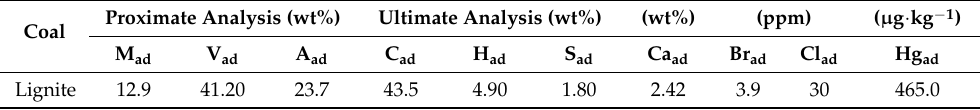
Table 5. Characteristic of the coal used in the experiment.